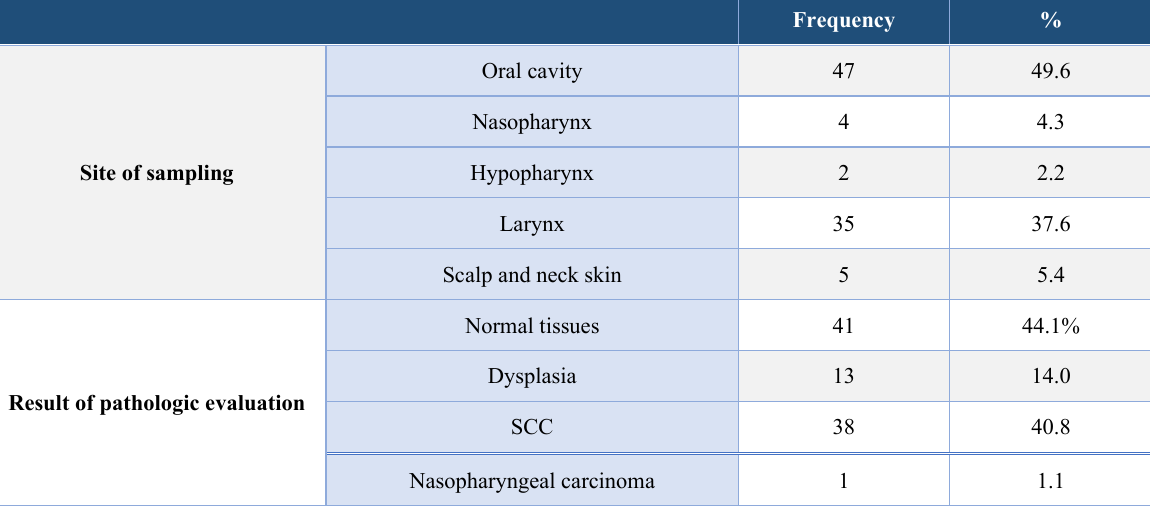
Table 1 . Pathological characteristics of samples